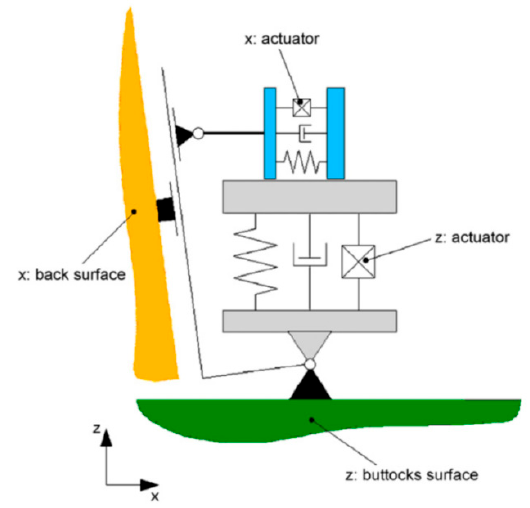
Figure 2. The schematic diagram of MEMOSIK V [10].